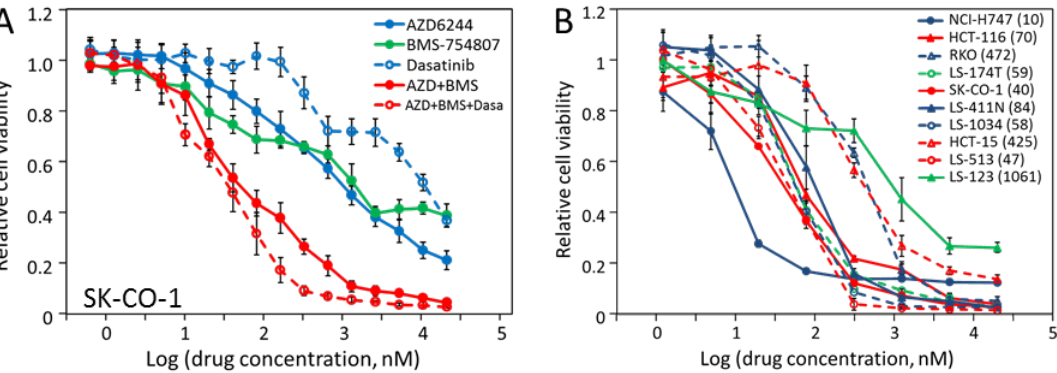
Figure 7. Inhibition of CRC cell proliferation by the triple combination of AZD-6244, BMS-754807 and dasatinib. ( A ) Response of SK-CO-1 to various drugs and drug combinations. The P values for comparing the AZD+BMS combination with either AZD-6244 or BMS-754807 are reported in Figure 4A. The P value for comparing the AZD+BMS+dasatinib triple combination to AZD+BMS double combination is 0.0066. ( B ) The inhibition of the proliferation of all CRC cell lines by the triple combination of AZD-6244, BMS-754807 and dasatinib (1:1:1 ratio) was determined as described in Materials and Methods. The IC 50 (in nM) of the triple combination against each cell line is given in the parentheses following the name of the cell line.